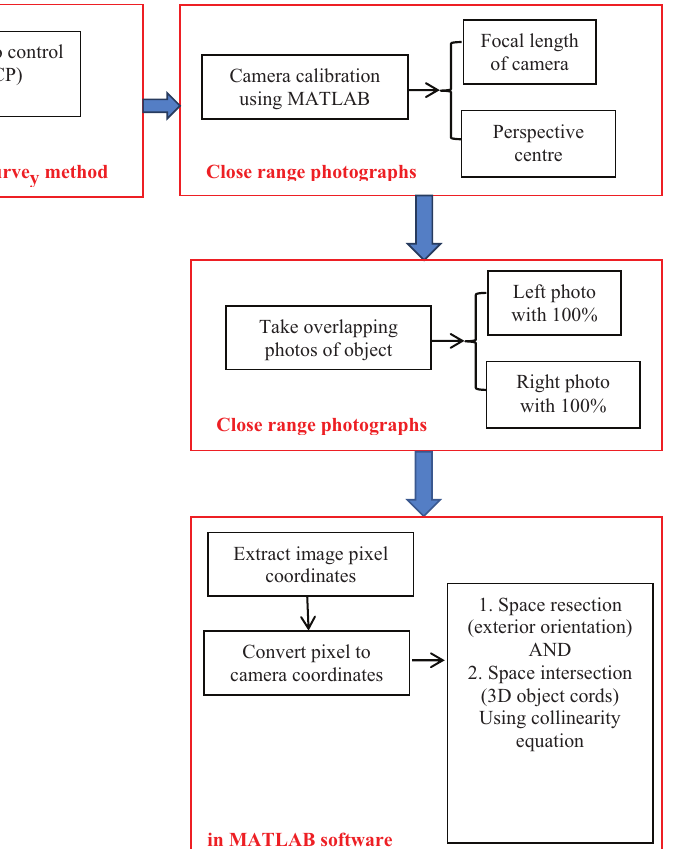
Figure 1. Flow diagram describing object coordinates determination approach